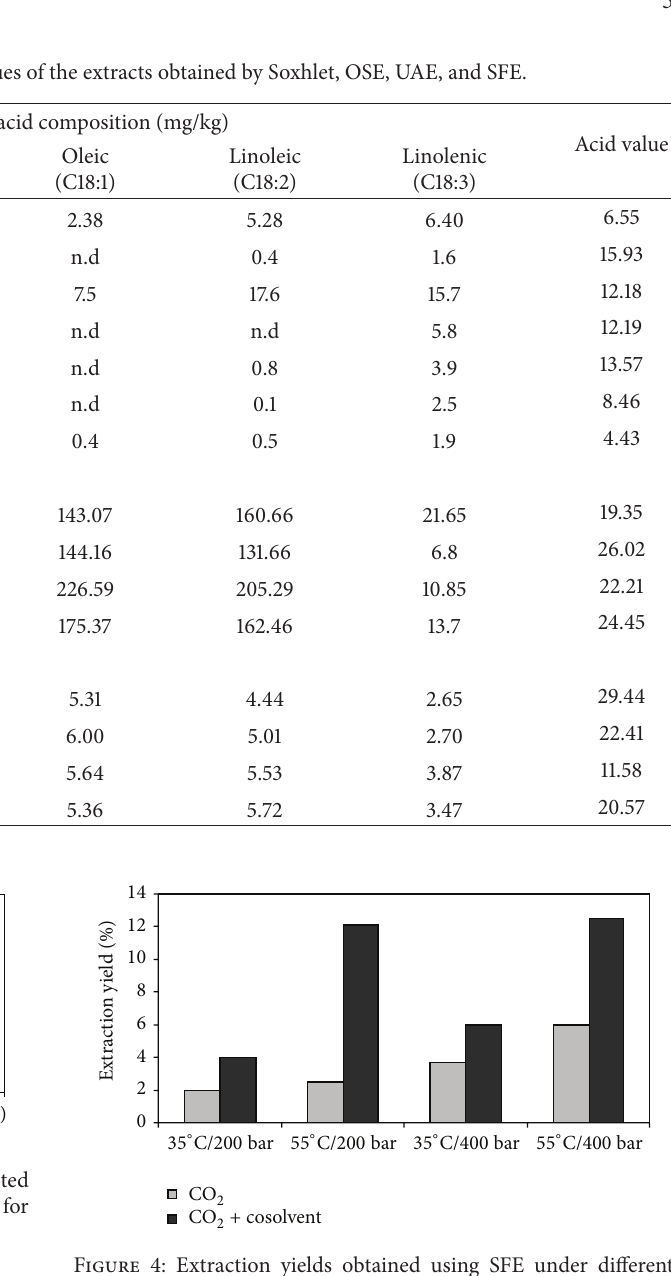
Figure 4: Extraction yields obtained using SFE under different temperature/pressure